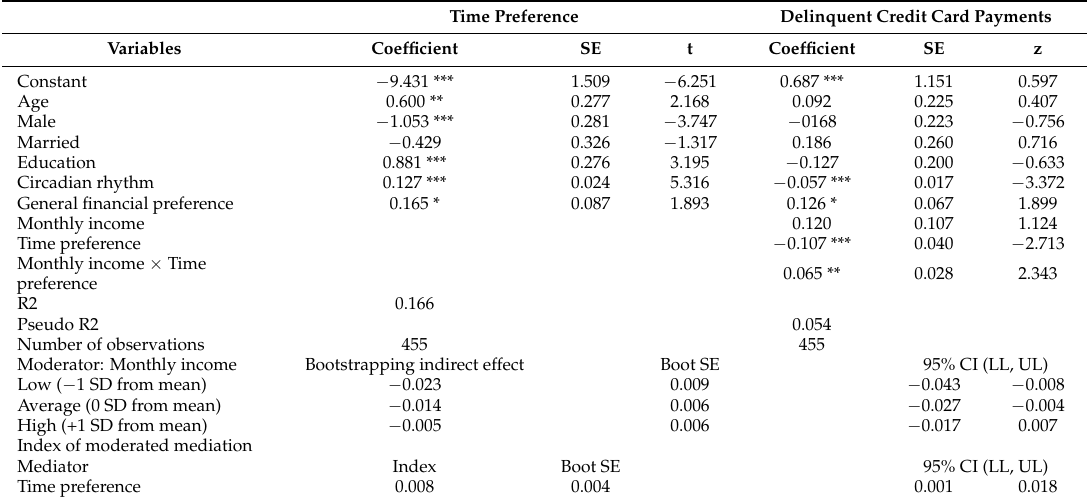
Table A3. The conditional indirect effect of circadian rhythm on delinquent credit card payments.